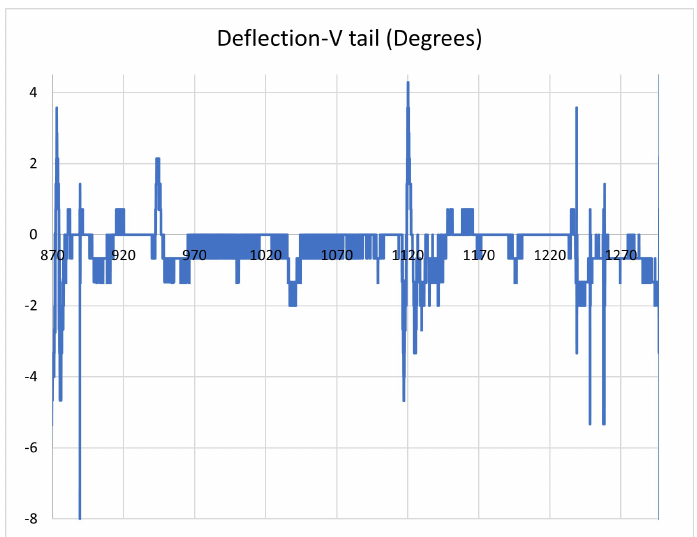
Figure 2. V Tail